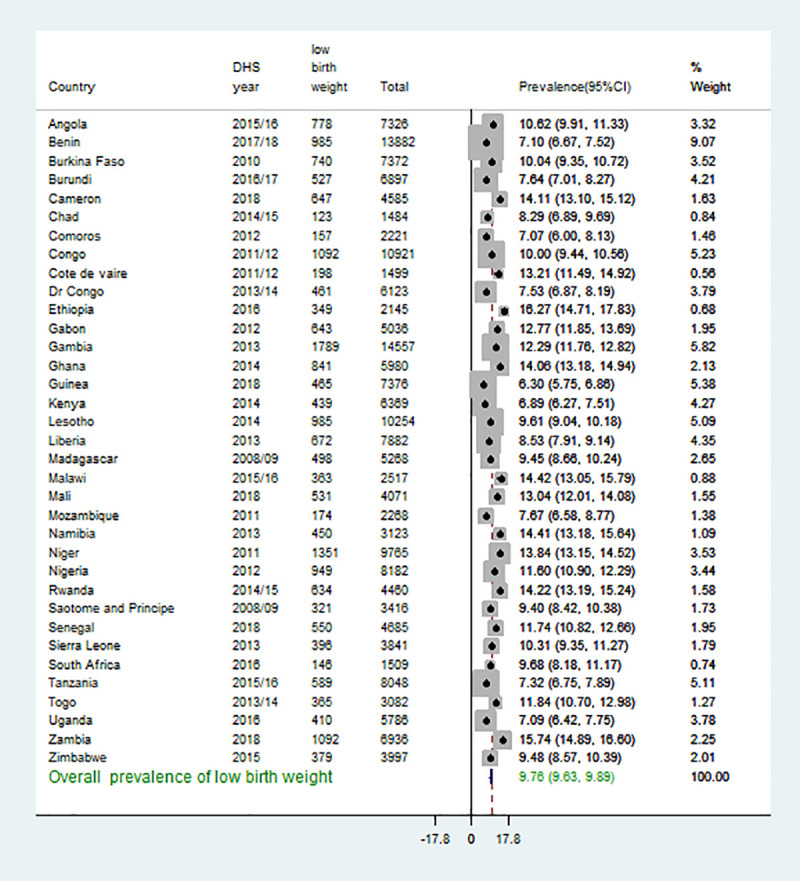
Forest plot of pooled prevalence of low birth weight of new babies measured at birth in SSA.